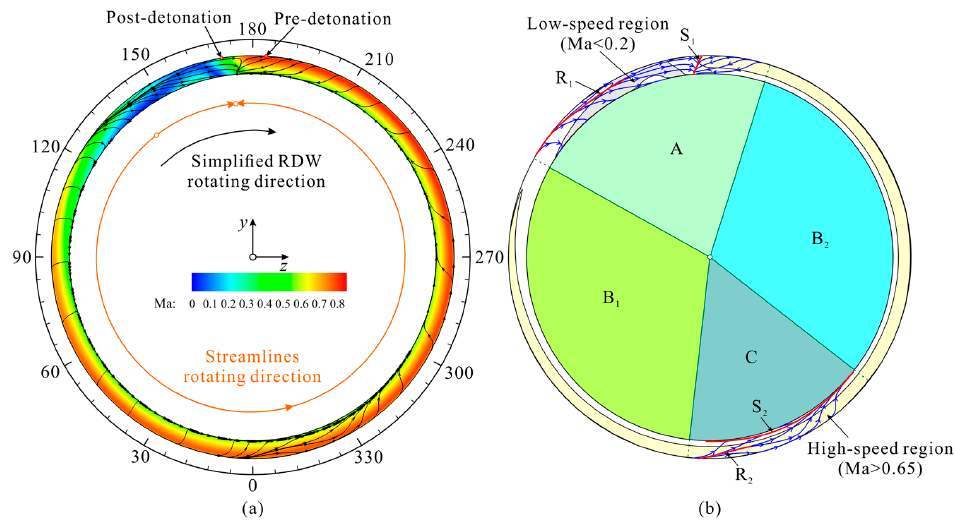
Figure 12. Flow topology on the exit. ( a ) Absolute Mach number contour and the streamlines. ( b ) Sketch of the distilled flow structure.